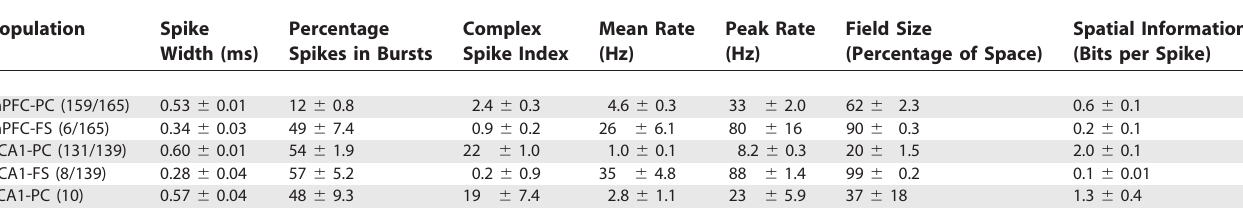
Table 1. Spike Waveform, Burst Firing, Firing Rate, and Spatial Firing Parameters for the mPFC and CA1 Populations